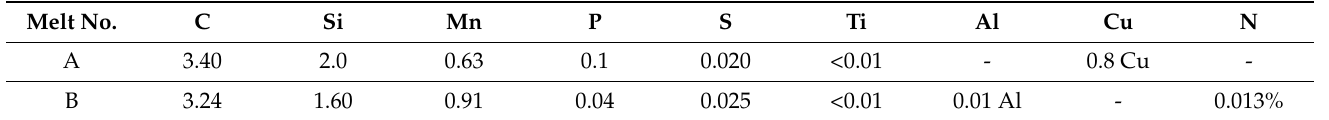
Table 1. Chemical composition of grey cast iron industrial research (%